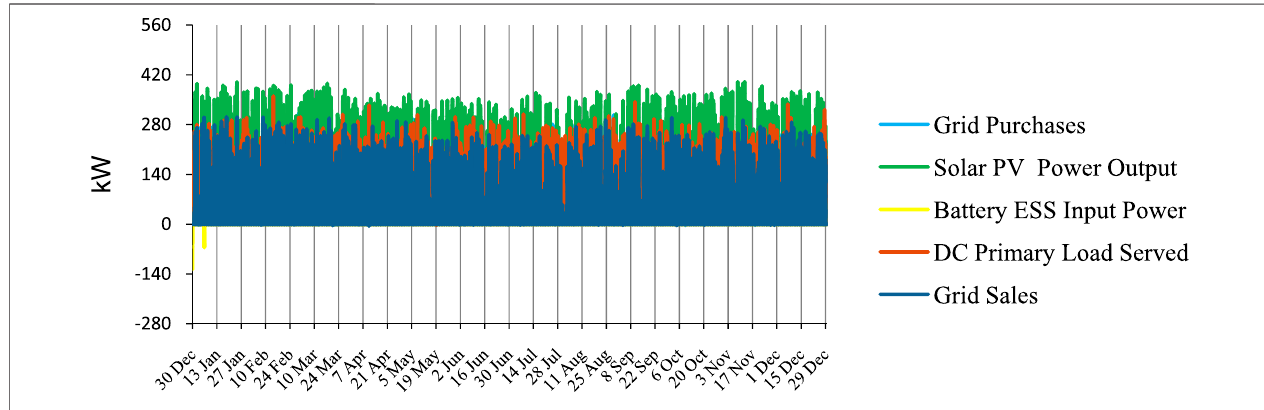
FIGURE 17 | Time series charts of the system.